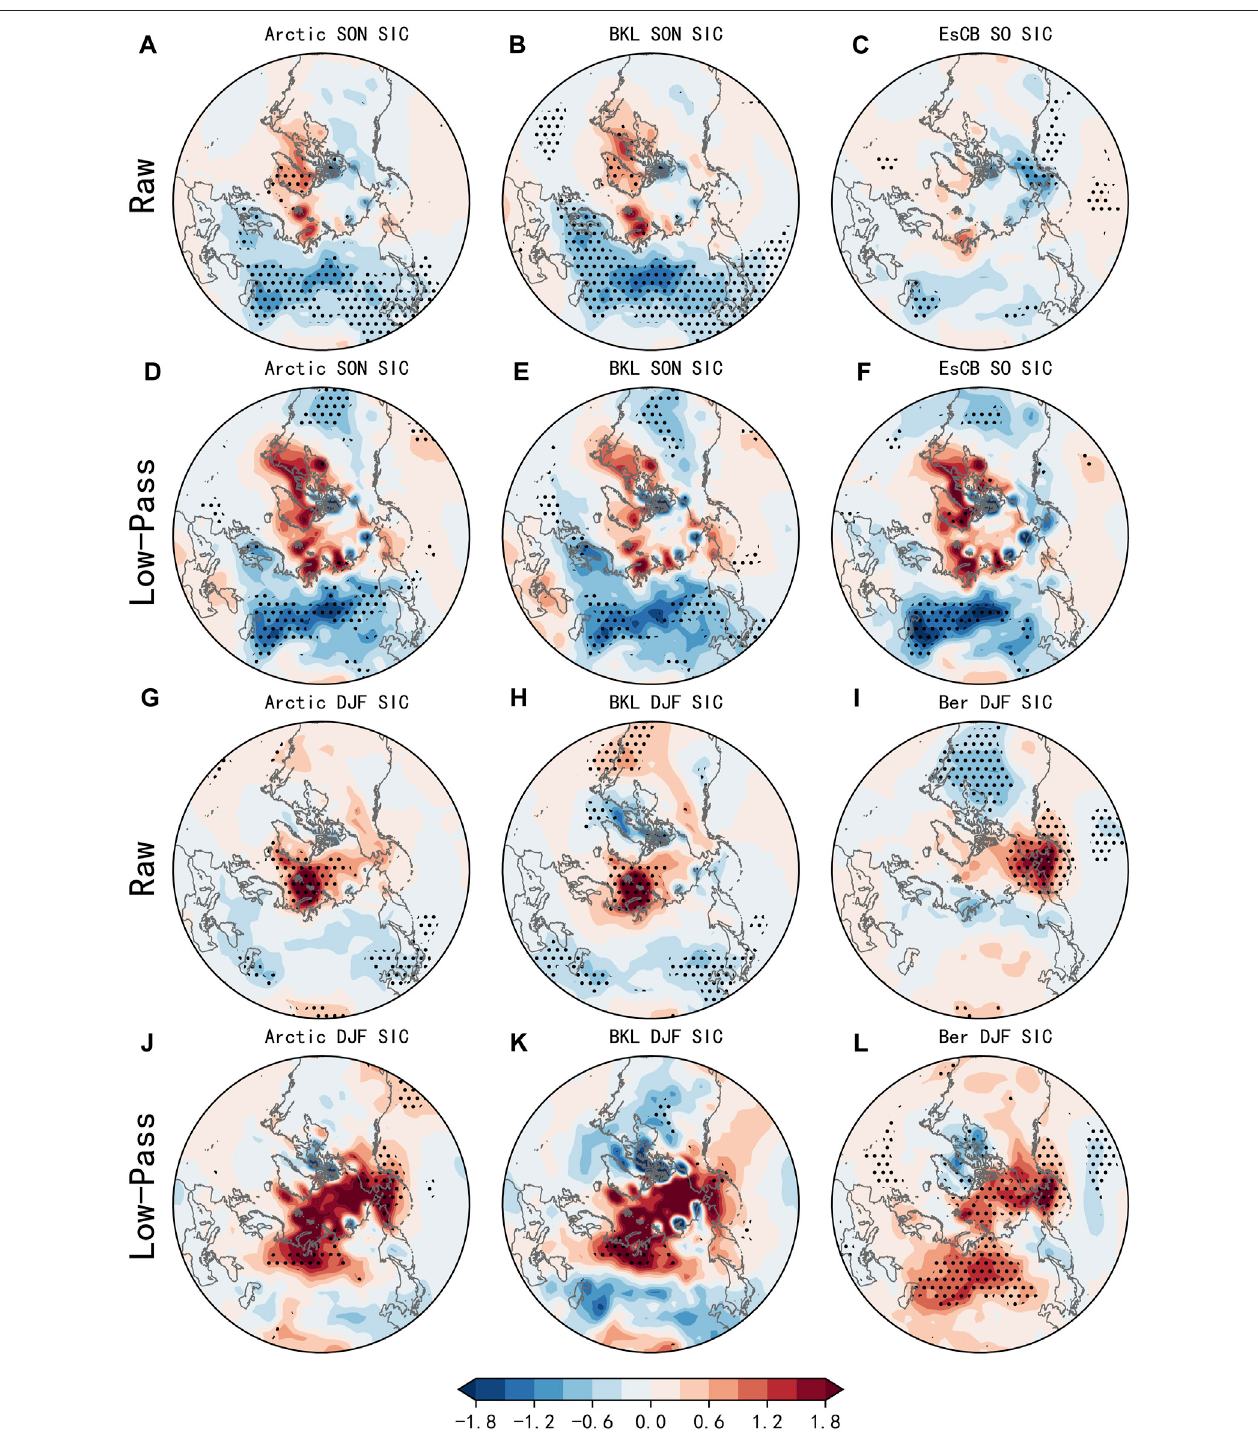
FIGURE 3 | Linear regression of winter surface air temperature (SAT; unit: K) anomalies against the Pan-Arctic, BKL and EsCB SIC indices (A – C) and associated interdecadal component (D – F) in autumn. (G – L) As in (A – F) but for SIC indices in winter. Stippling indicates SAT anomalies that are statistically signi fi cant at the 95% con fi dence level.